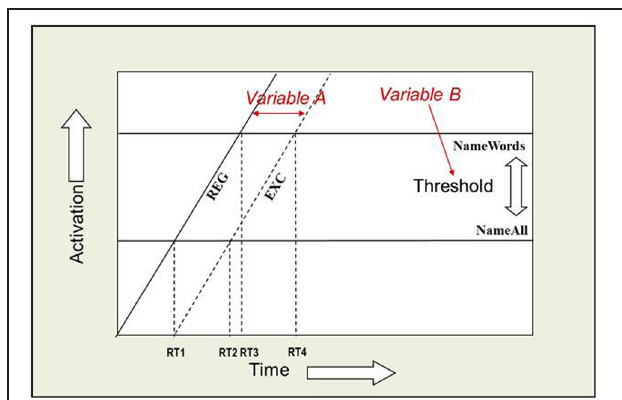
FIGURE 3 | Additive joint effects between INST and WT. An Additive Factors Method interpretation of this additive effect is that INST and WT are affecting separable systems in time. If INST are assumed to affect the threshold for activation (i.e., the amount of time it takes to verify that a letter string spells a word), and WT is assumed to shift the rate of activation over time (i.e., the time it takes to choose among the competing phonological codes for EXCs), or vice versa, then the points in time when each rate crosses a threshold correspond to the average onset RTs. [(RT4 −